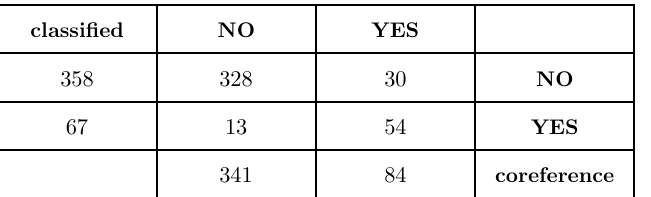
Table 4. Confusion matrix on the testing set, only for the